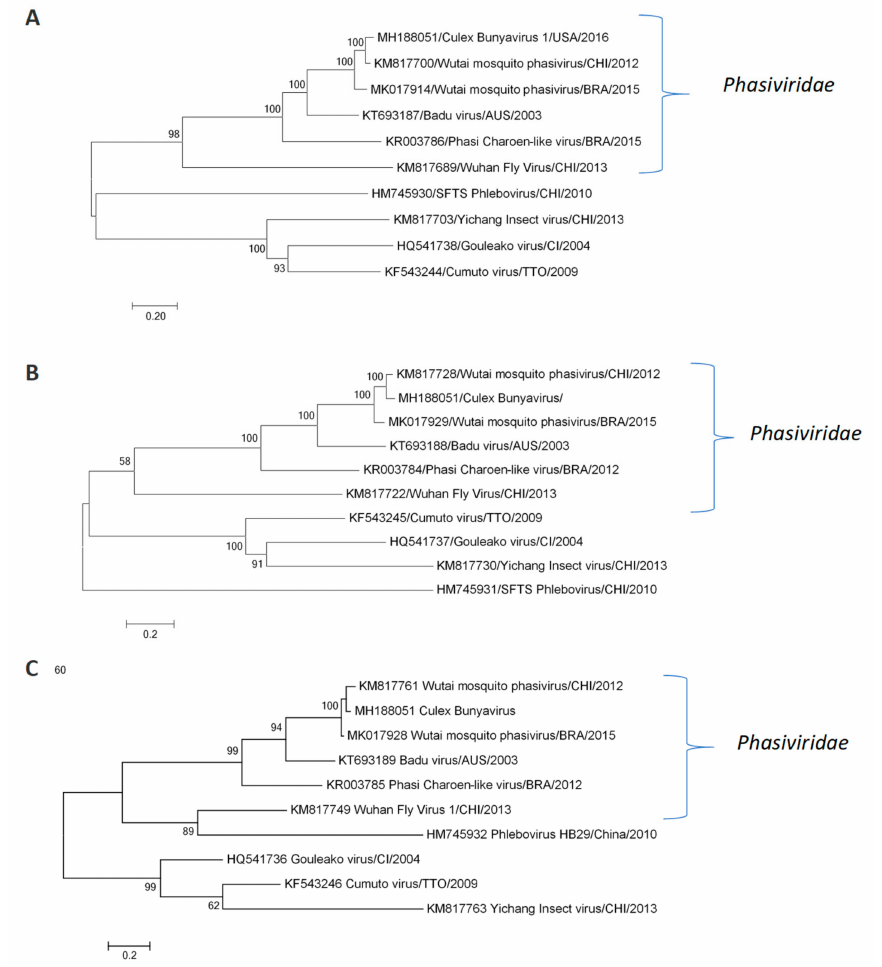
Figure 2. Genetic relationship of Wutai mosquito phasivirus with other members of the Phasiviridae family and other related bunyaviruses. Phylogenetic trees were constructed for ( A ) L segment (5800 bp); ( B ) M segment (2620 bp); and ( C ) S segment (511 pb). The evolutionary history was inferred by using the Maximum Likelihood method based on the General Time Reversible model for segments L and M and on the Tamura 3-parameter model for segment S [15]. A discrete Gamma distribution was used to model evolutionary rate di ff erences among sites (5 categories). The rate variation model allowed for some sites to be evolutionarily invariable for segments L and M. The trees are drawn to scale, with branch lengths measured in the number of substitutions per site. All positions containing gaps and missing data were eliminated. Evolutionary analyses were conducted in MEGA7 [16], with 1000 replicates. Only bootstrap values > 70% are shown at the